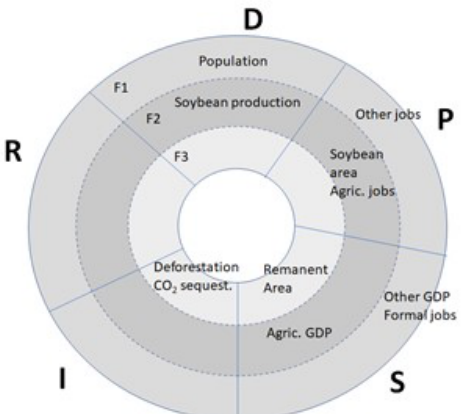
Figure 5. A diagram displays the indicators evaluated structured according to the combination of the DPSIR framework and the Factors extracted from the factor